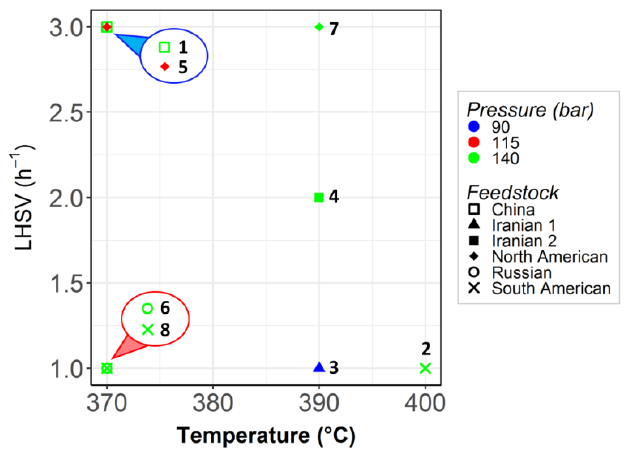
Figure 8. Operating conditions of eight selected episodes (liquid hourly space velocity (LHSV) vs. temperature).